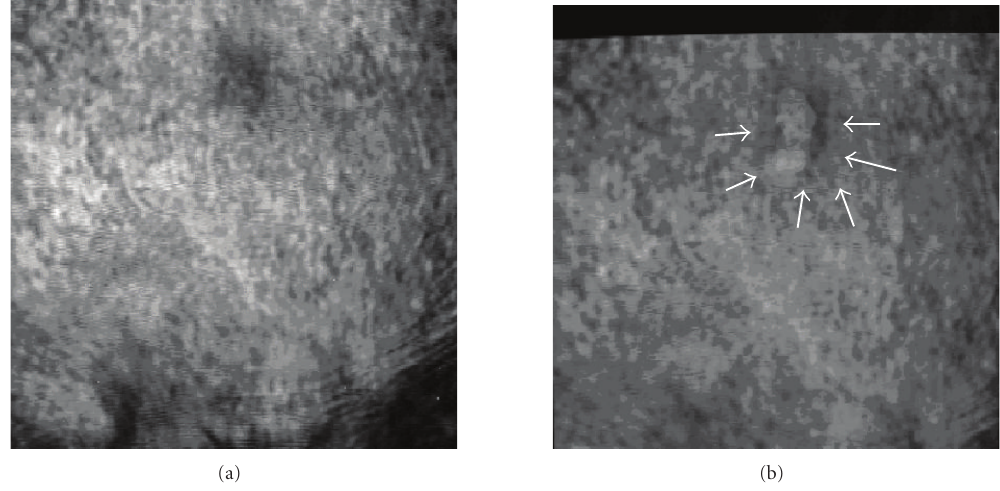
Figure 7: (a) The original VA image; (b) the fusion of VA with marked